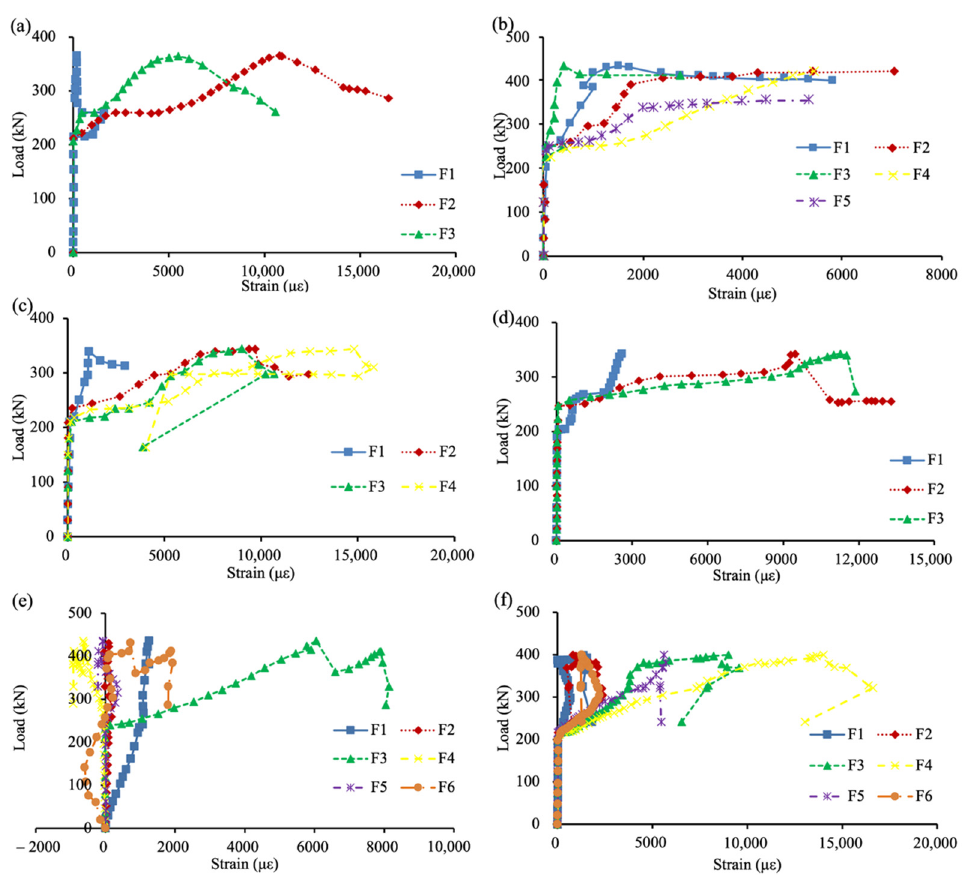
Figure 9. Load–strain relation of FFRP stirrups in specimen: ( a ) 10 × 30 @ 200; ( b ) 20 × 30 @ 100; ( c ) 20 × 30 @ 150; ( d ) 20 × 30 @ 200; ( e ) 10 × 60 @ 100; and ( f ) 20 × 60 @